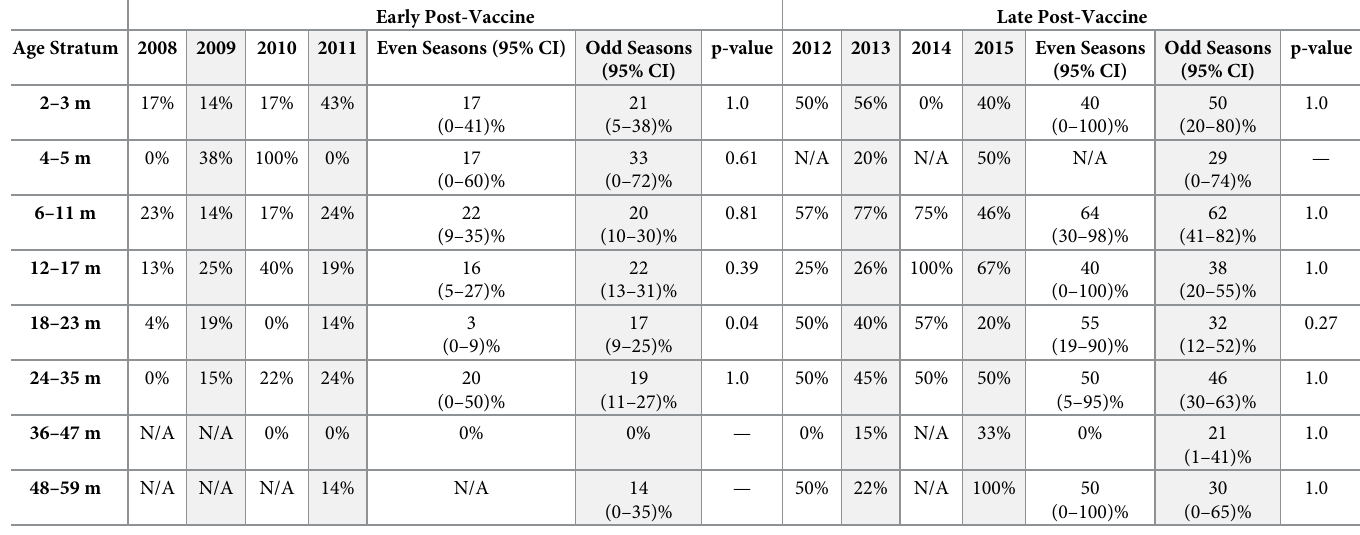
Table 3. Rotavirus vaccination coverage ( (cid:21) 1 rotavirus vaccination) stratified by age and rotavirus season (Jan-Jun) for children < 60 months hospitalized for rota- virus, 2008–2015. P-value comparison is for odd vs. even seasons. Early Post-Vaccine